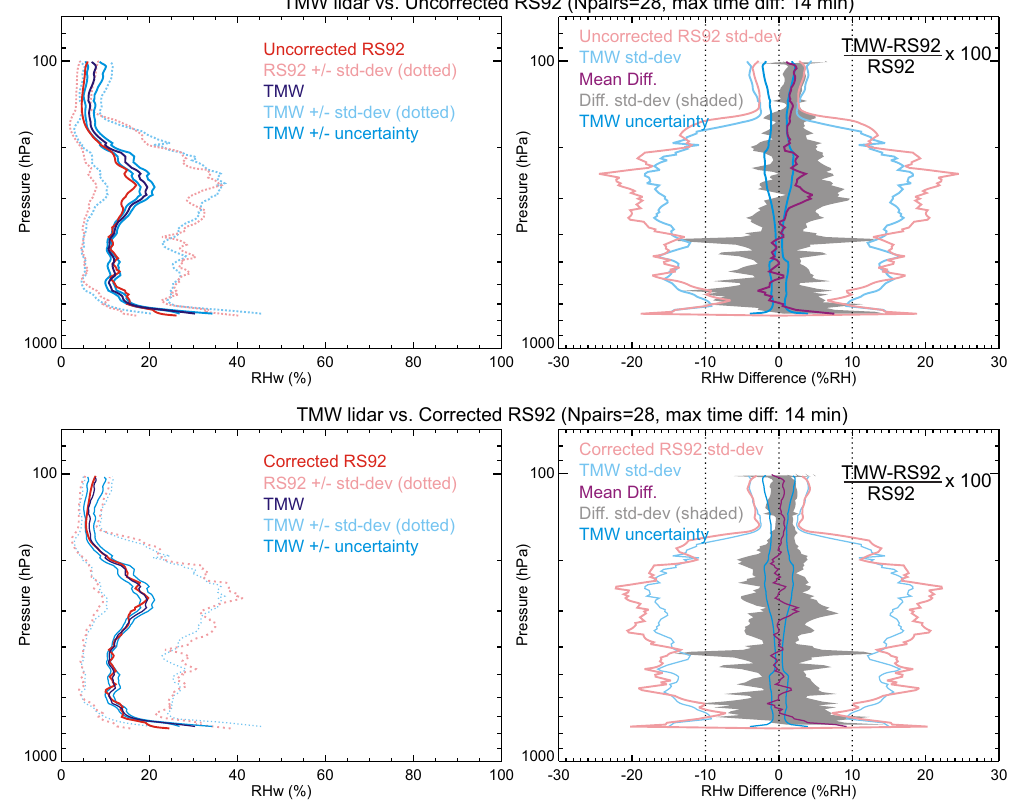
Fig. 13. Comparison of the MOHAVE-2009 campaign-averaged relative humidity profiles calculated from the 28 simultaneous profiles measured by the TMW lidar and Vaisala RS92 radiosondes. Top plots: mean profiles (left) and difference with the uncorrected RS92 data (right). Bottom plots: mean profiles (left) and difference with the corrected (Miloshevich et al., 2004; 2009) RS92 data (right). obtained from a 1-h integration starting at the corresponding balloon launch time. The CFH campaign-mean profile is pro- vided on each plot for reference purposes only. 18 and 20 Oc- tober (top-left and top-right) illustrate the very large natural variability in the troposphere from one night to another: very humid upper troposphere on 18 October and very dry on 20 October. Most of the very fine vertical structures (some- times less than 1-km deep) are well captured by all balloon- borne and lidar instruments. A well-known RS92 dry bias is again systematically observed above 12 km (cyan